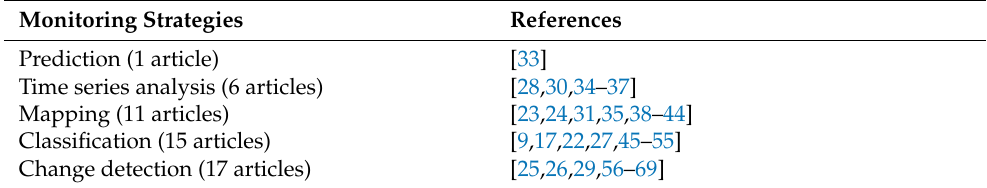
Table 2. The subclasses of wetland monitoring strategies in the analysed articles.